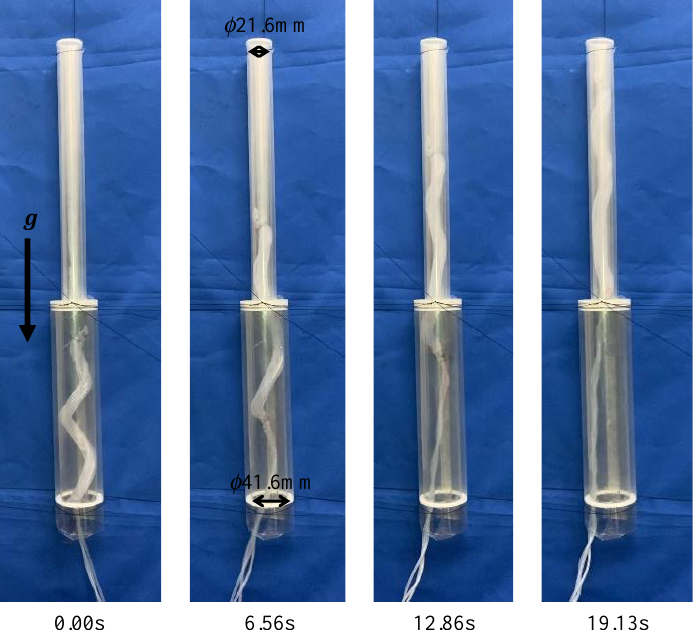
Figure 18. Experiment using a biased pitch device, driven by an air pressure of 0.15 MPa into a vertically fixed pipe with the same diameter as that of the 40A and the